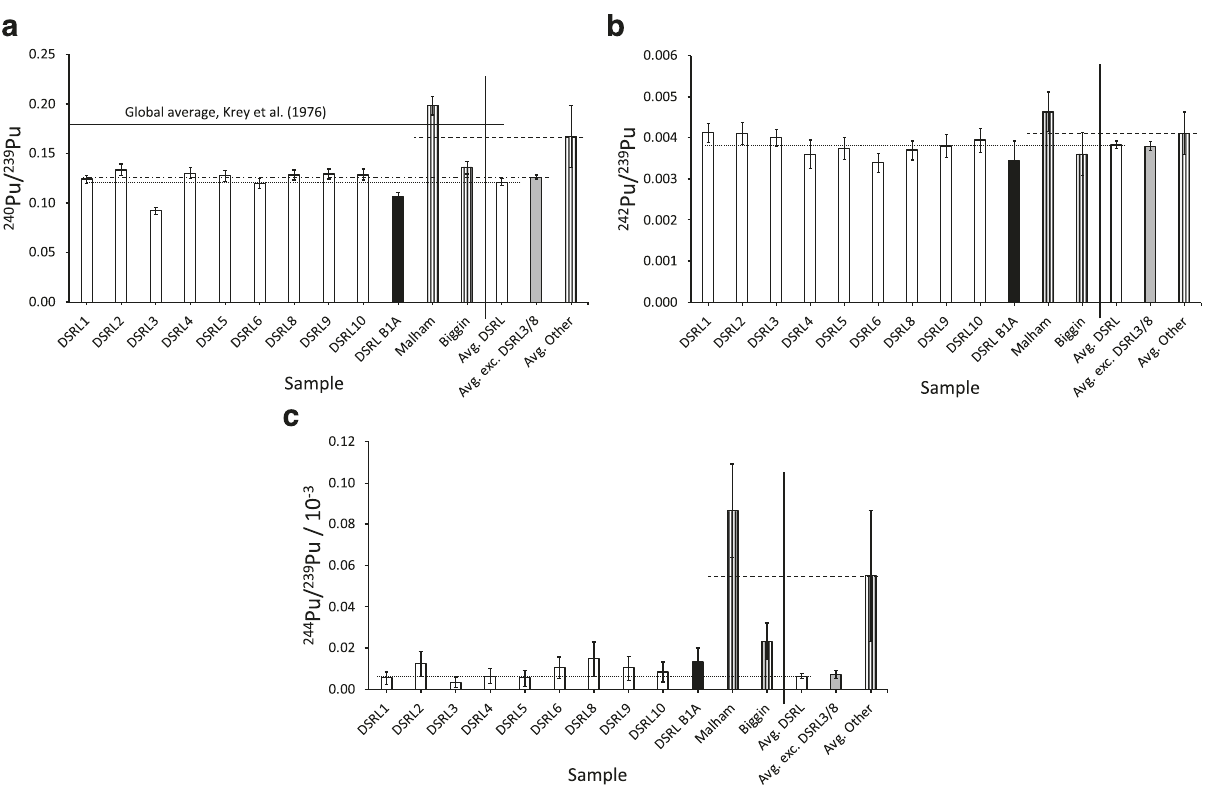
Fig. 3 Isotopic ratios for plutonium. a 240 Pu/ 239 Pu, b 242 Pu/ 239 Pu and c 244 Pu/ 239 Pu. Uncertainties are depicted by ±1 σ error bars. Data for samples taken on-site at Dounreay and the corresponding weighted averages (where applicable to the right of the vertical solid line) are depicted as white bars, the off-site nearby sample by the black bar and off-site far away samples by bars with vertical stripes (the weighted average for the on-site data excluding samples DSRL3 and DSRL8 is denoted by the shaded grey bar). The horizontal lines represent the weighted averages of the ratios on-site at Dounreay (dotted), on-site excluding DSDRL3 and DSRL8 (dotted-dashed, where a difference is apparent) and off-site-far (dashed). The solid horizontal line in a corresponds to the global average for the 240 Pu/ 239 Pu ratio reported by Krey et al. 3 , as labelled, of 0.176 ± 0.02. The corresponding data for the weighted averages for on-site, off-site nearby, Malham and Biggin are given in Table 2.